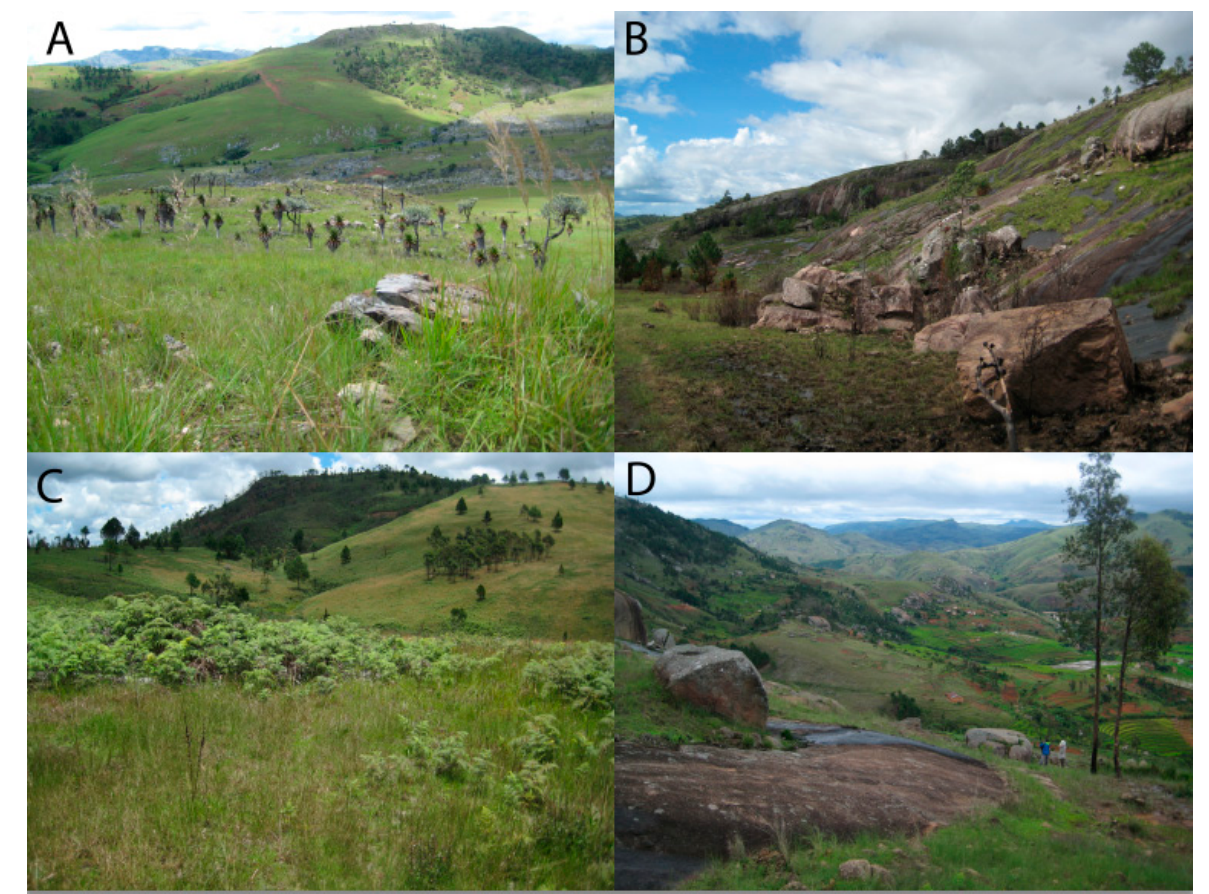
Figure 2. Topography of four of the collection sites; ( A ) Mountainous, outcrops of marble and quartzite, ( B ) Base of wide valley with granite slabs and large, fast-flowing river, ( C ) Rolling hills with few granite outcrops, ( D ) Steep hills with boulders. Table 1. Description of collection sites detailing locality, topography, and vegetation.